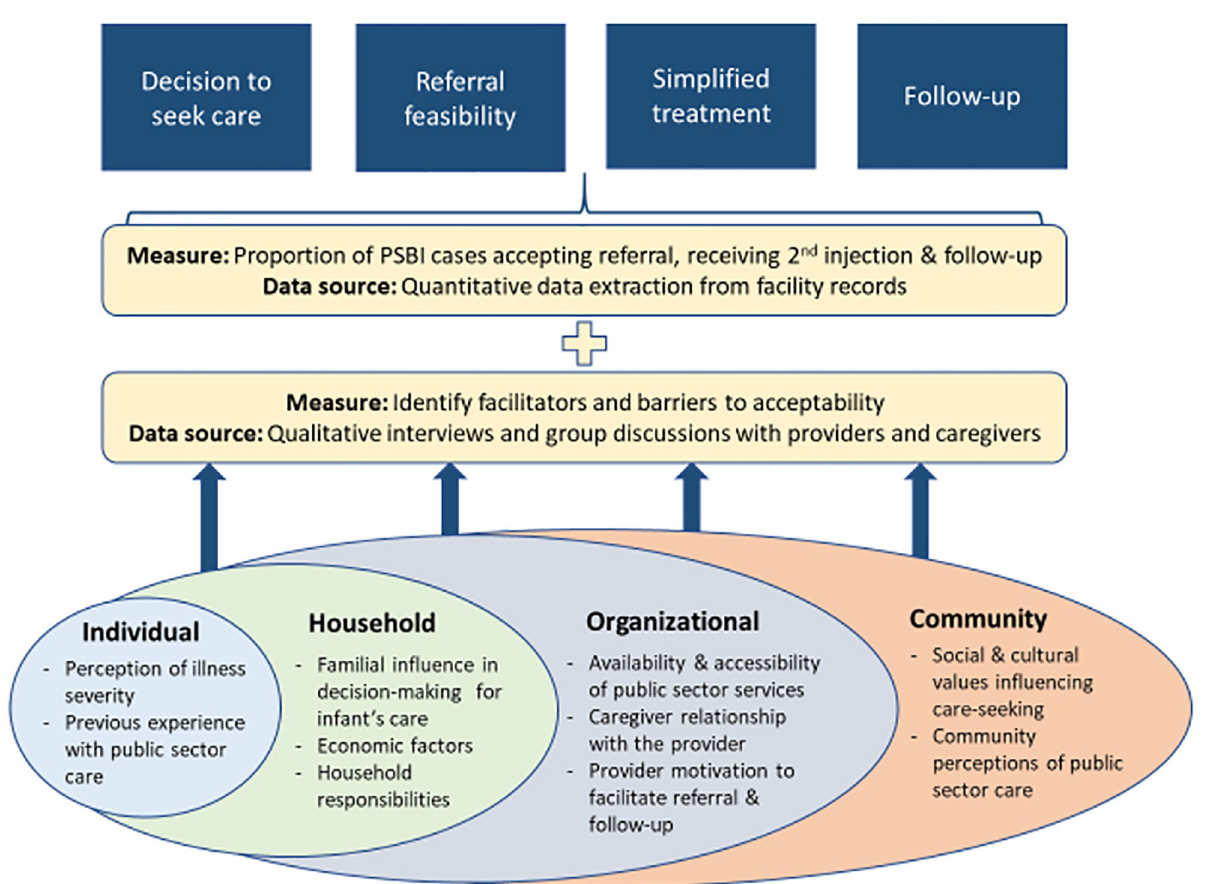
Fig 2. Adapted socioecological model for analysis of embedded mixed methods study to assess caregiver acceptability of key components of infection management guidelines.